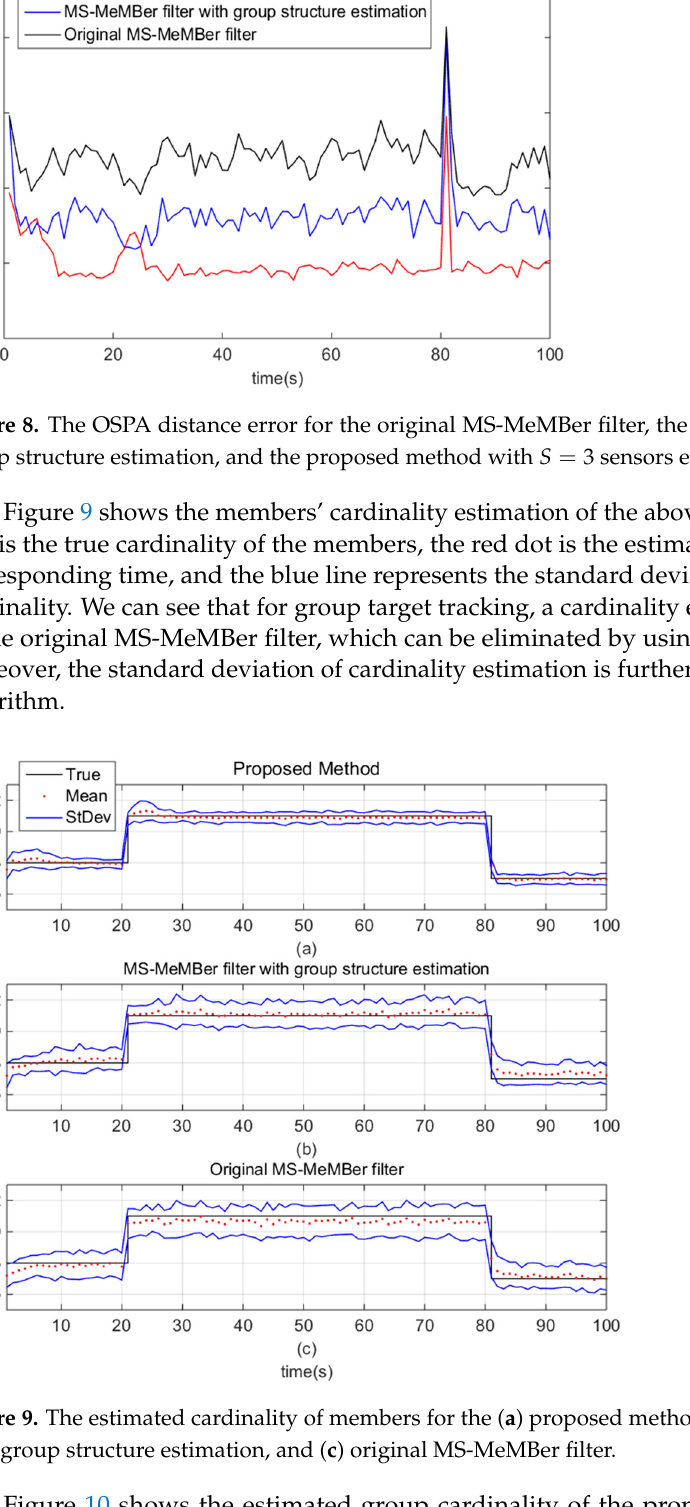
Figure 9. The estimated cardinality of members for the ( a ) proposed method, ( b ) MS-MeMBer filter with group structure estimation, and ( c ) original MS-MeMBer filter.